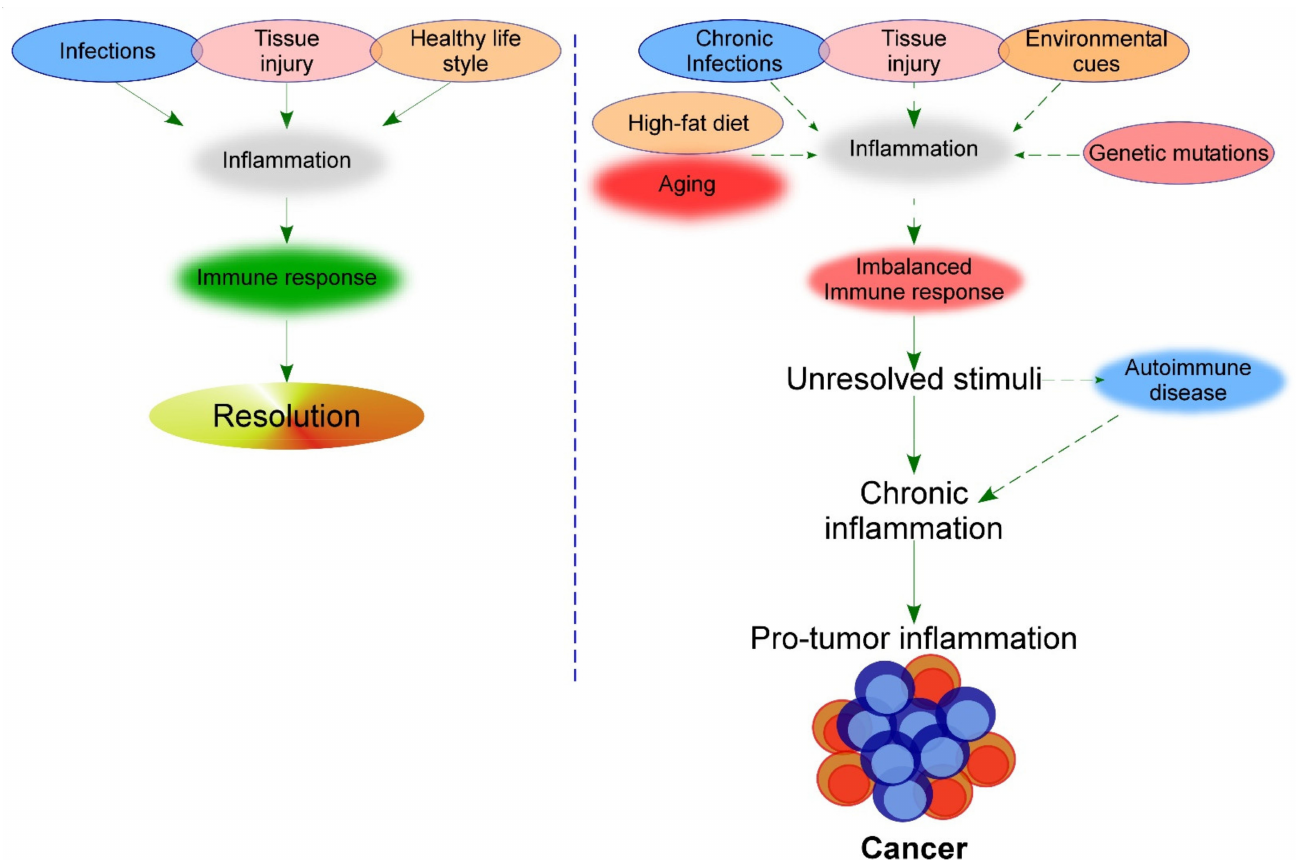
Figure 1. Intrinsic and external triggers that impact the immune response. Panel on the left shows insults that activate the immune response in a healthy life. Panel on the right shows different triggers that occur with aging that cause an inadequate immune